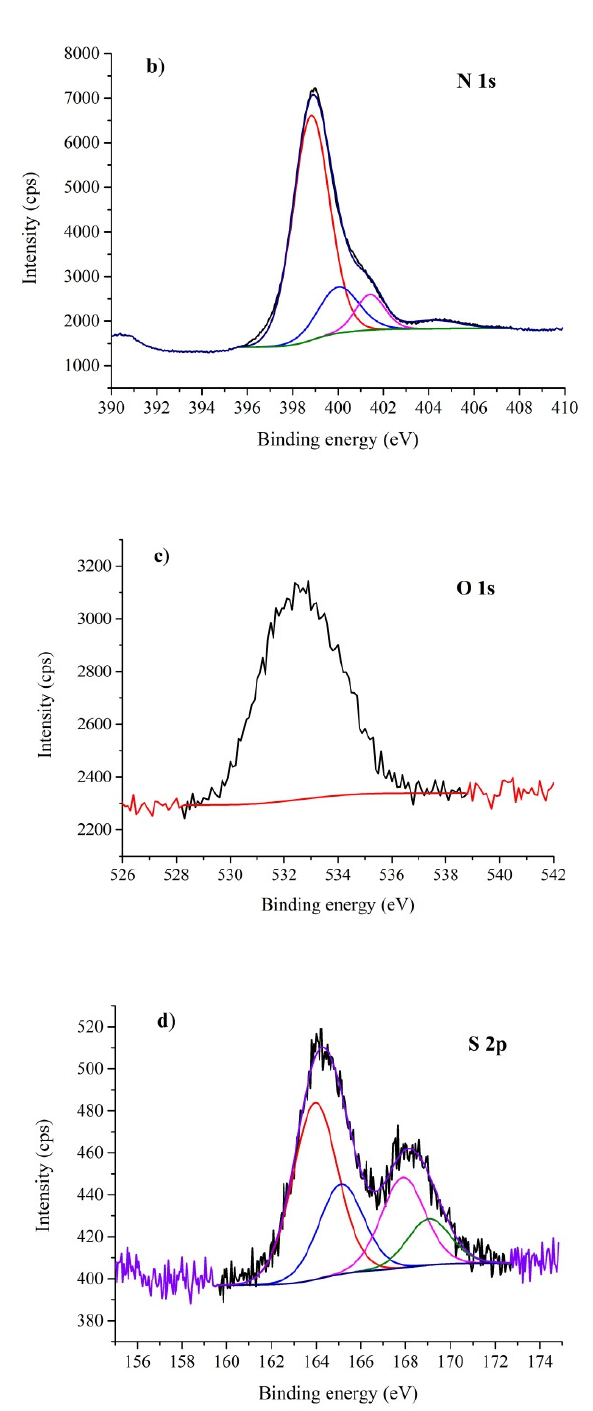
Figure 5. X-ray photoelectron spectrometer (XPS) spectra of Mes-ExCN. ( a ) C 1s, ( b ) N 1S, ( c ) O 1s, ( d ) S 2p.